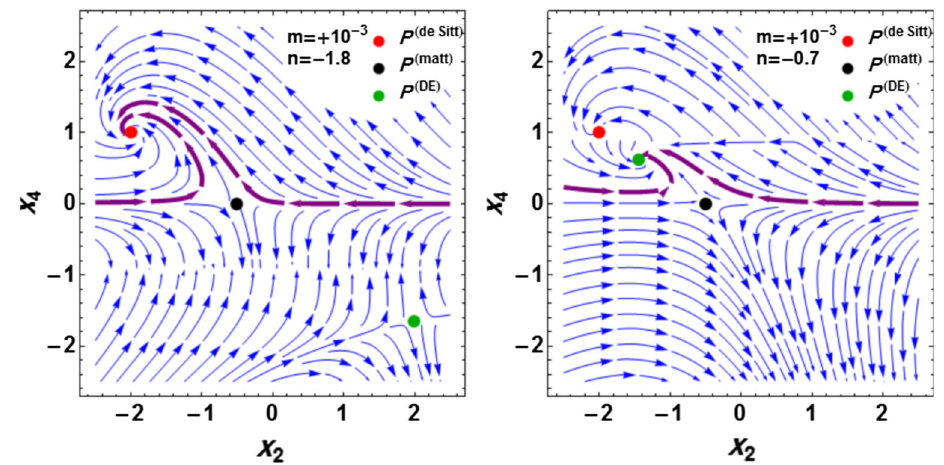
Fig. 3 The situation of the two fixed points, i.e., DE and de Sitter solu- tions for the model f ( R , T ) = R α + ( − T ) β and for two different values of n parameter. The left panel in the green point represents an unstable DE solution. The right panel in the green point represents a stable DE